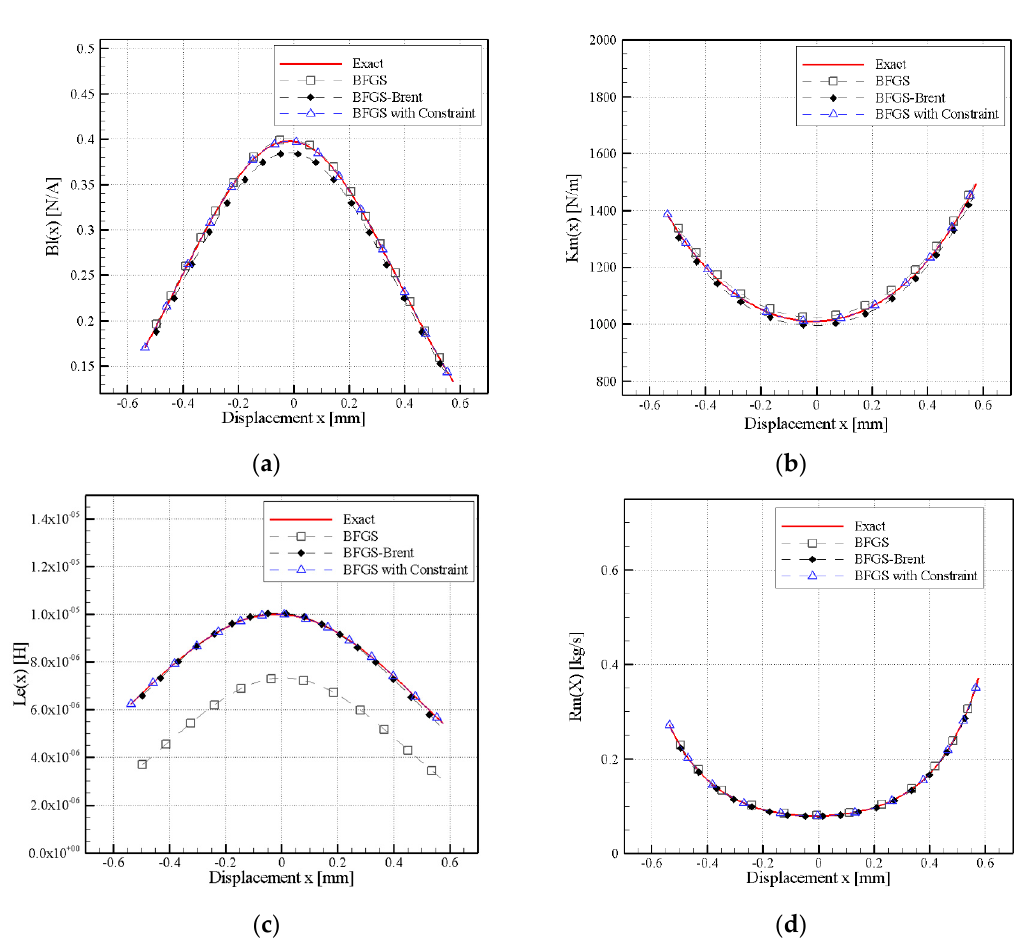
Figure 3. Comparison of exact and inverse values, ( a ) Bl ( x ), ( b ) K m ( x ), ( c ) L e ( x ), and ( d ) R m ( x ).